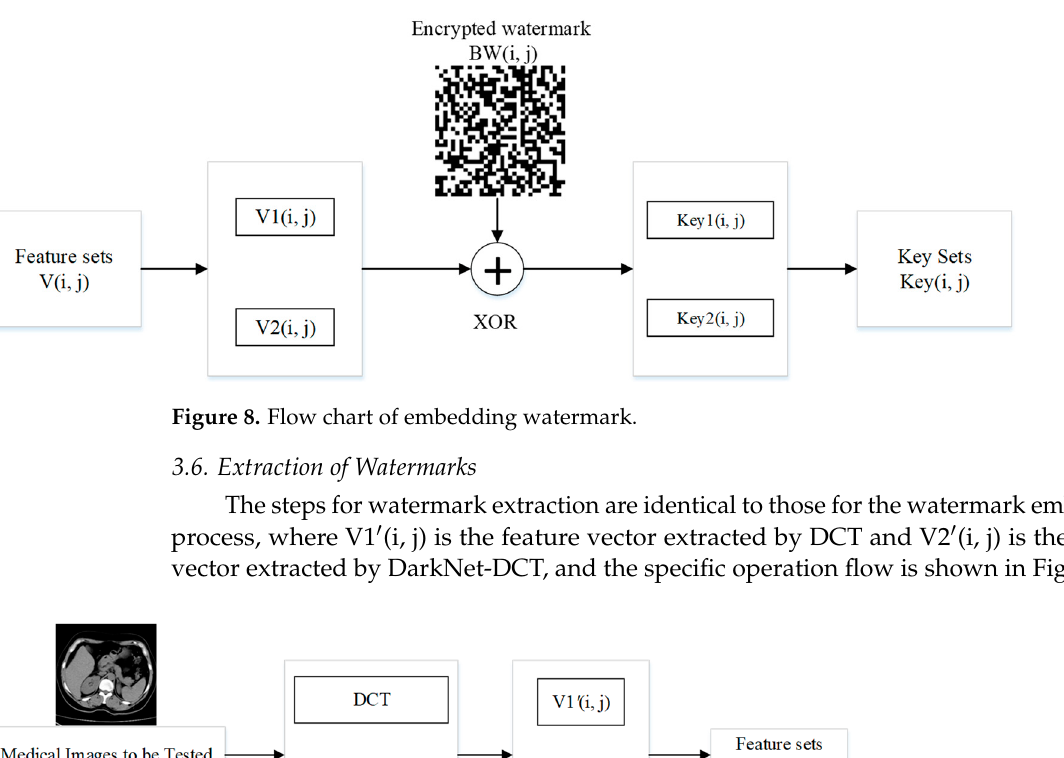
Figure 7. Extraction process of encrypted medical image features.